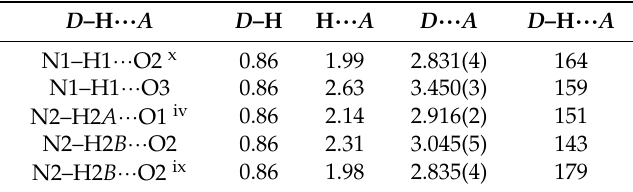
Table 4. Hydrogen-bond geometry (Å, ◦ ) for ( III ).